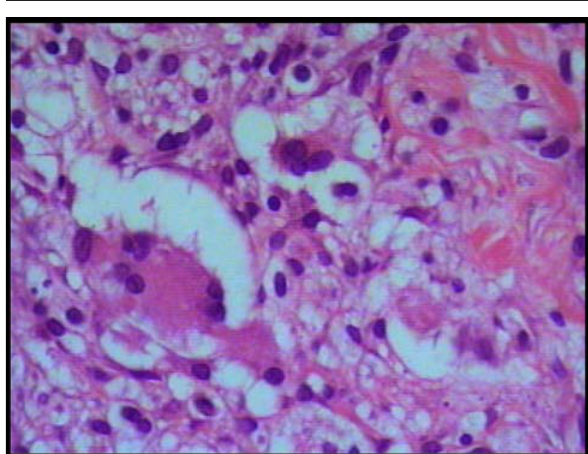
FIGURE 6 - Photomicrography with 4X lens (40X enlargement) of histological slice taken from the skin of a group C rat, stained with HE, showing stroma with edema, loose connective tissue and neovessels